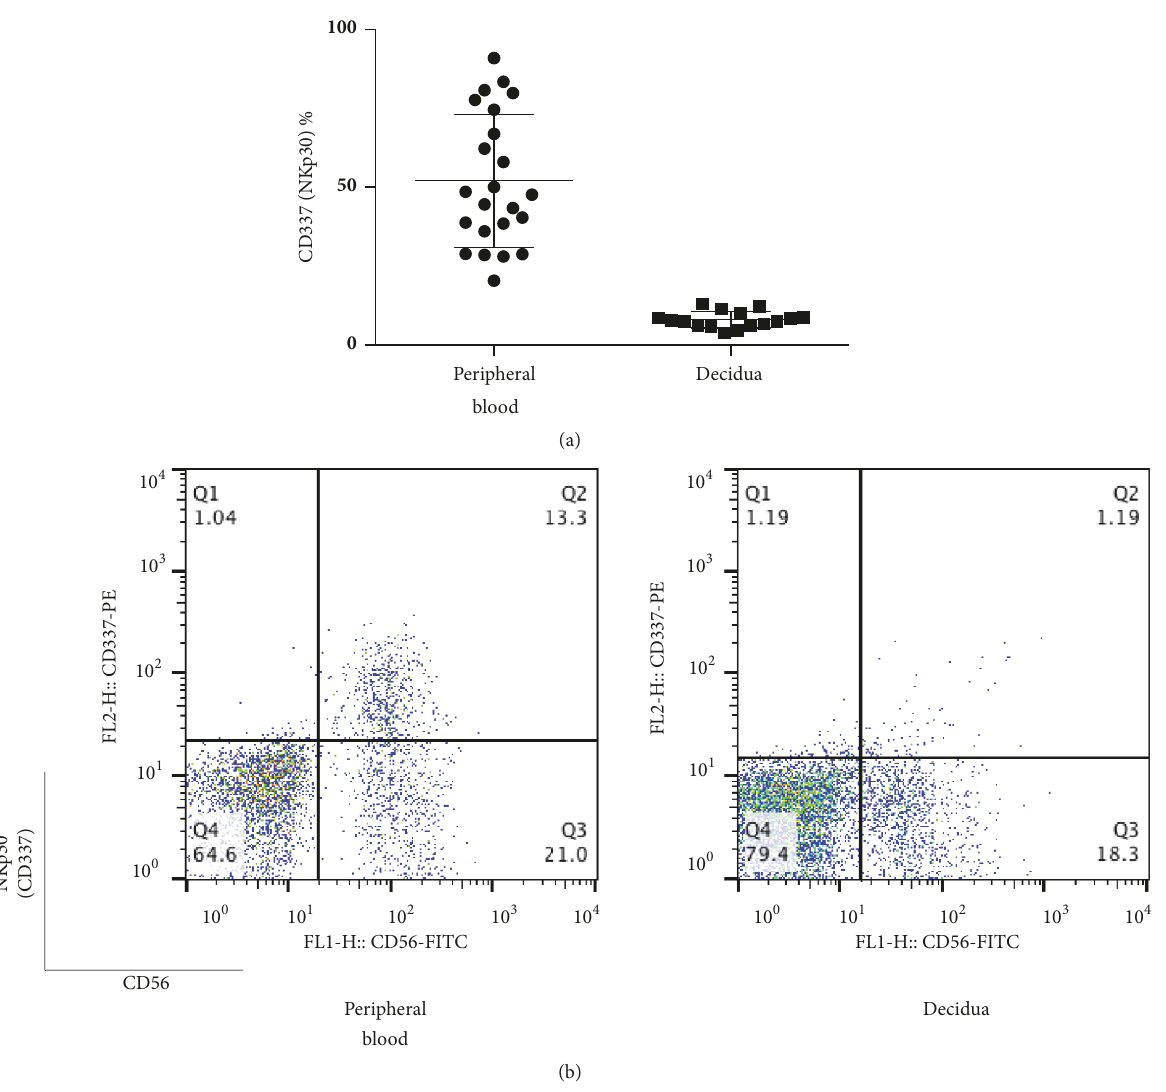
Figure 5: (a) Percentage of CD337 (NKp30)+ cells among CD56+CD3 − cells at term pregnancy in peripheral blood and decidua. The percentage of CD337 (NKp30)+ cells in CD56+3- lymphocytes was lower than in peripheral blood. (b) Representative dot plot analysis of CD337 (NKp30)+ cells among CD56+CD3- lymphocytes taken from term pregnancy by flow cytometry. The gate was set around the CD3- lymphocytes to analyze the CD337+CD56+ NK